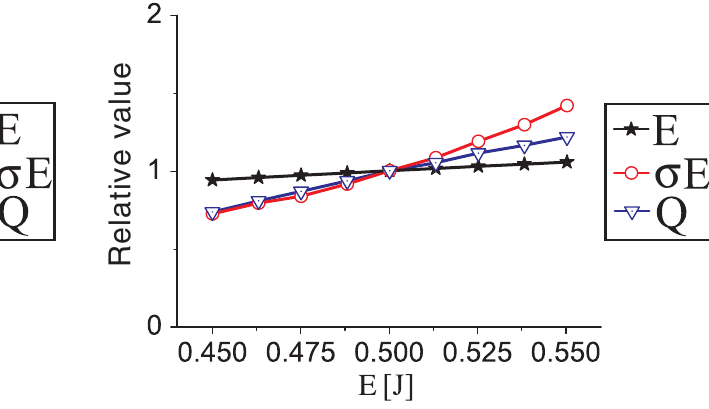
FIG. 4. (Color) Effect of (cid:1) 500 fs fluctuations in the timing between laser and electrons ( (cid:8)t > 0 means the electrons are injected further in front of the laser pulse) on the final beam parameters [energy ( E ), energy spread ( (cid:5)E ), and trapped fraction ( Q )] for injection 300 fs behind the laser pulse with a 0 ¼ 0 : 32